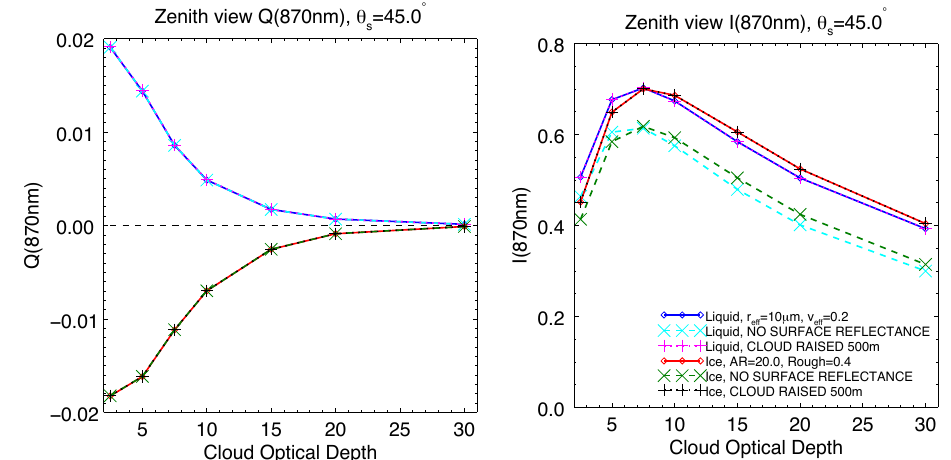
Figure 8. Simulated Q (left) and I (right) for liquid (blue, cyan, magenta) and ice (red, green, black) phase clouds observed from the ground by a polarimeter observing in the zenith direction at 870nm and with a solar zenith angle of θ s = 45 ◦ . Both the liquid and ice clouds were simulated with different surfaces reflectances (cyan and green) and altitudes (magenta and black). The left-most plot illustrates the lack of sensitivity to these changes for Q , while sensitivity to surface reflectance for I is shown on the right. Cloud base height does not strongly affect either Q or I .